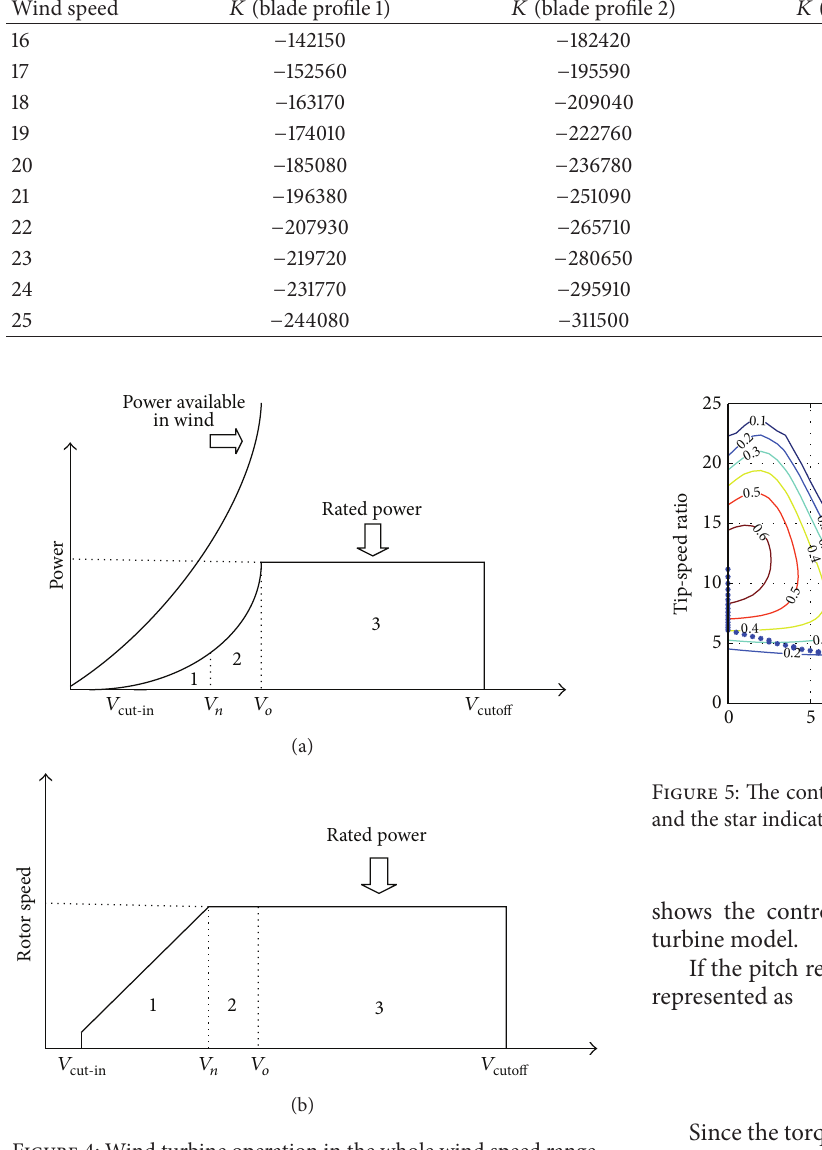
Figure 4: Wind turbine operation in the whole wind speed range.